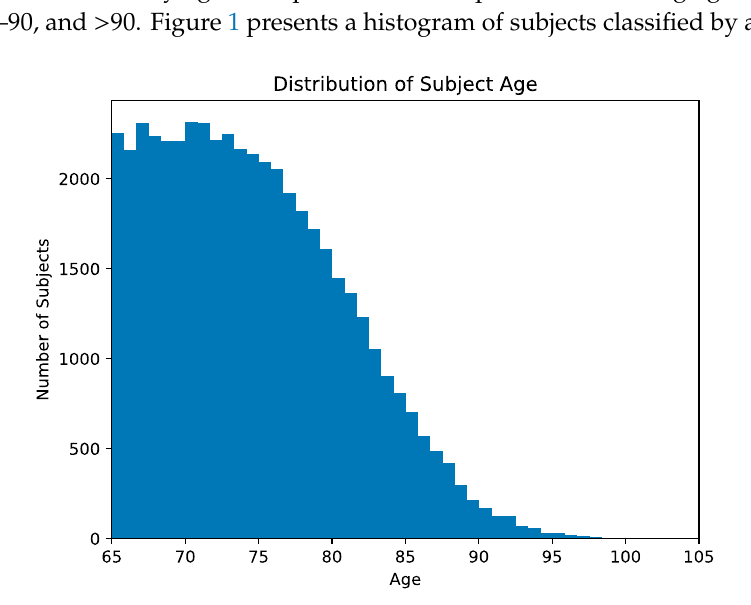
Figure 1. Presents a histogram of subjects classified by age.